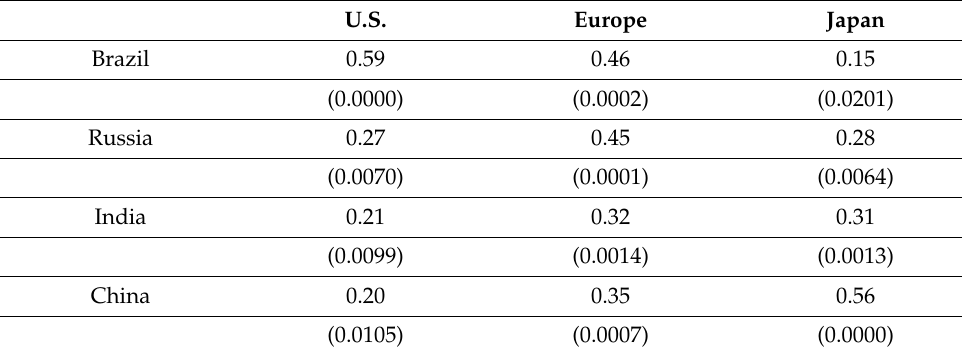
Table 3. Unconditional Daily Correlation between BRIC and Advanced Economies from January 2000 to May 2016 ( p -values in